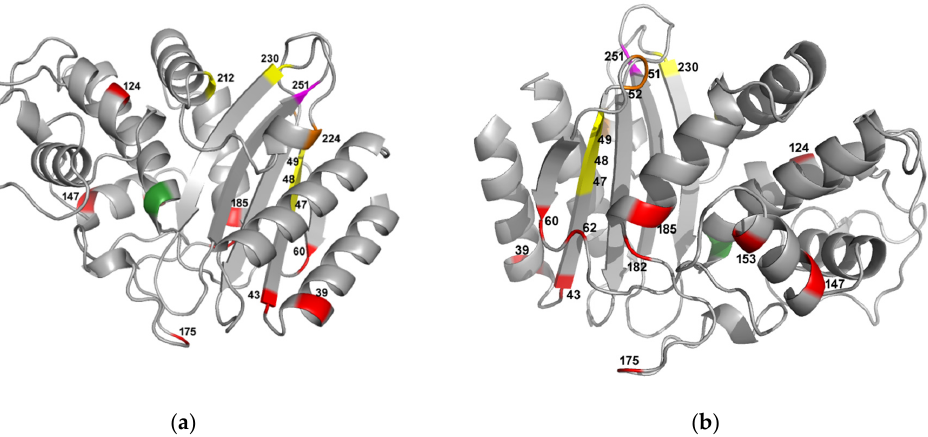
Figure 5. Two opposite faces of the protein ( a , b ). Sites with compensating mutations on G251W-TEM variant (pdb entry: 1 BTL) are indicated with different colors. The active site (S70) is indicated in green and site 251 in pink. Mutations with local effects (<13 Å from W251) are indicated in yellow, and those with a global effect are in red. Mutations located <13 Å from W251 but previously described with a global stabilizing effect on the protein are indicated in orange.